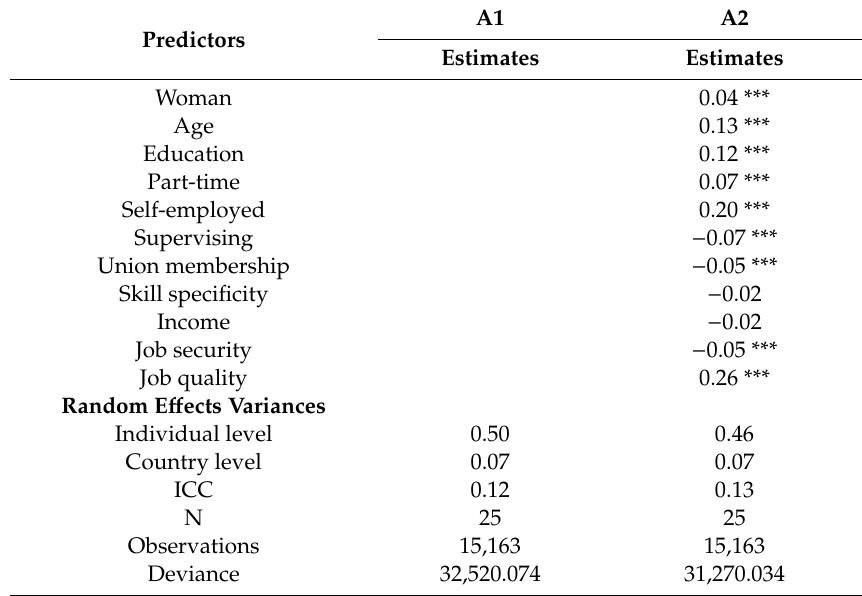
Table 1. E ff ects of individual-level characteristics on job preference orientations; multi-level